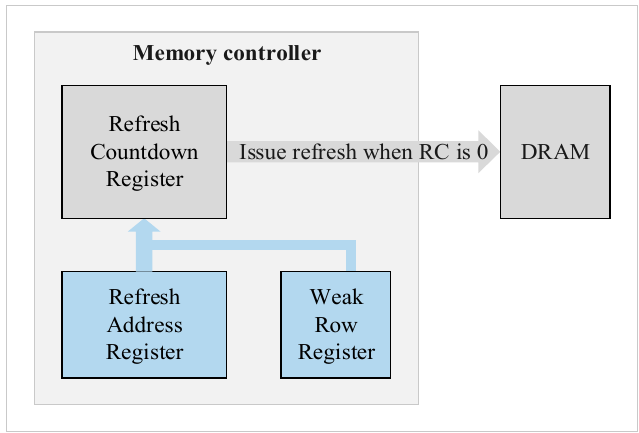
Figure 10. Modified memory controller.